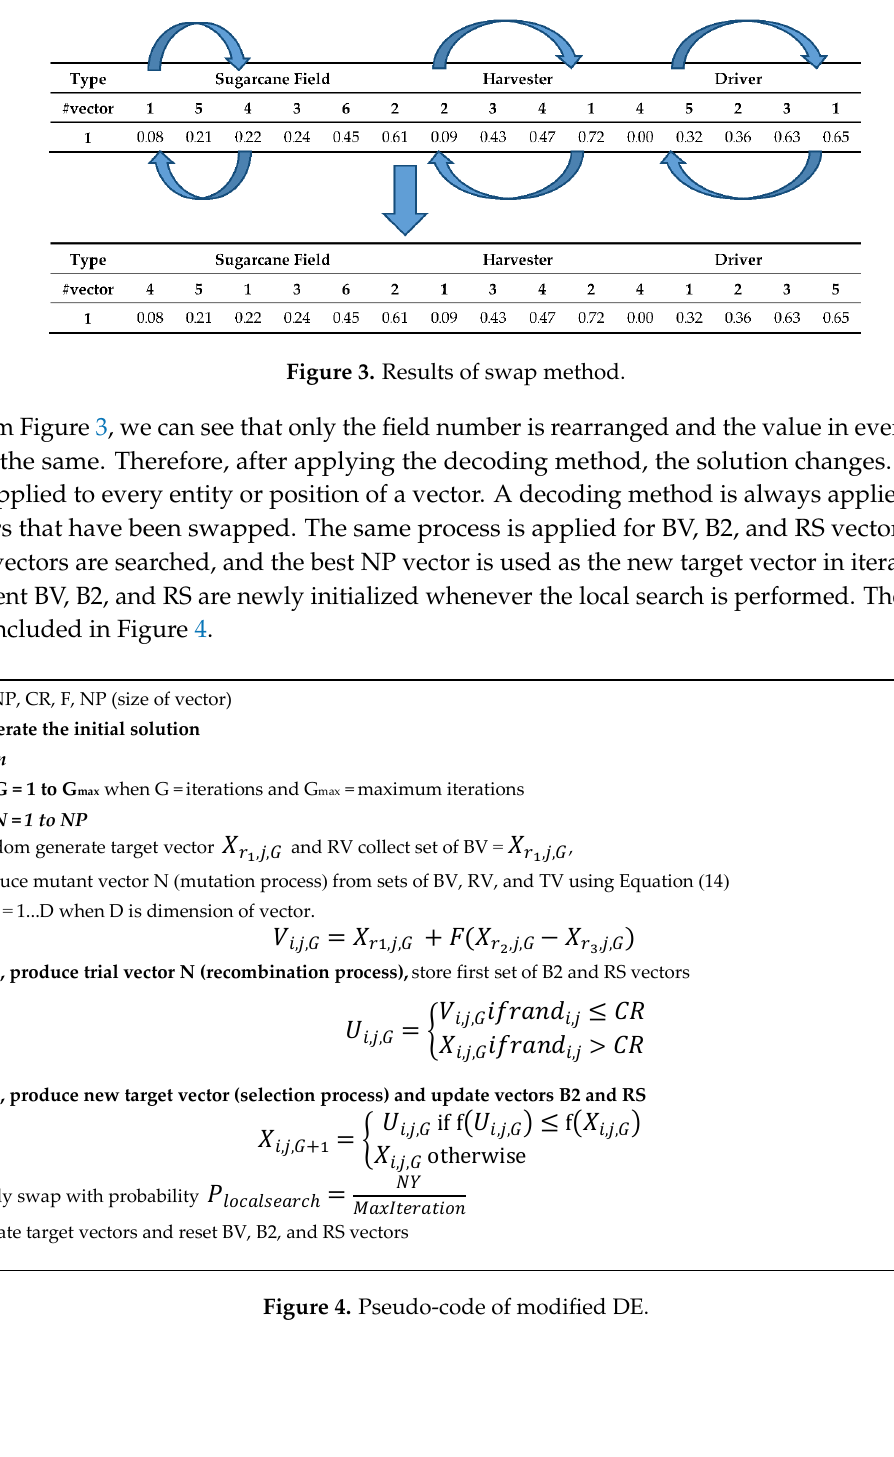
Figure 3. Results of swap method.